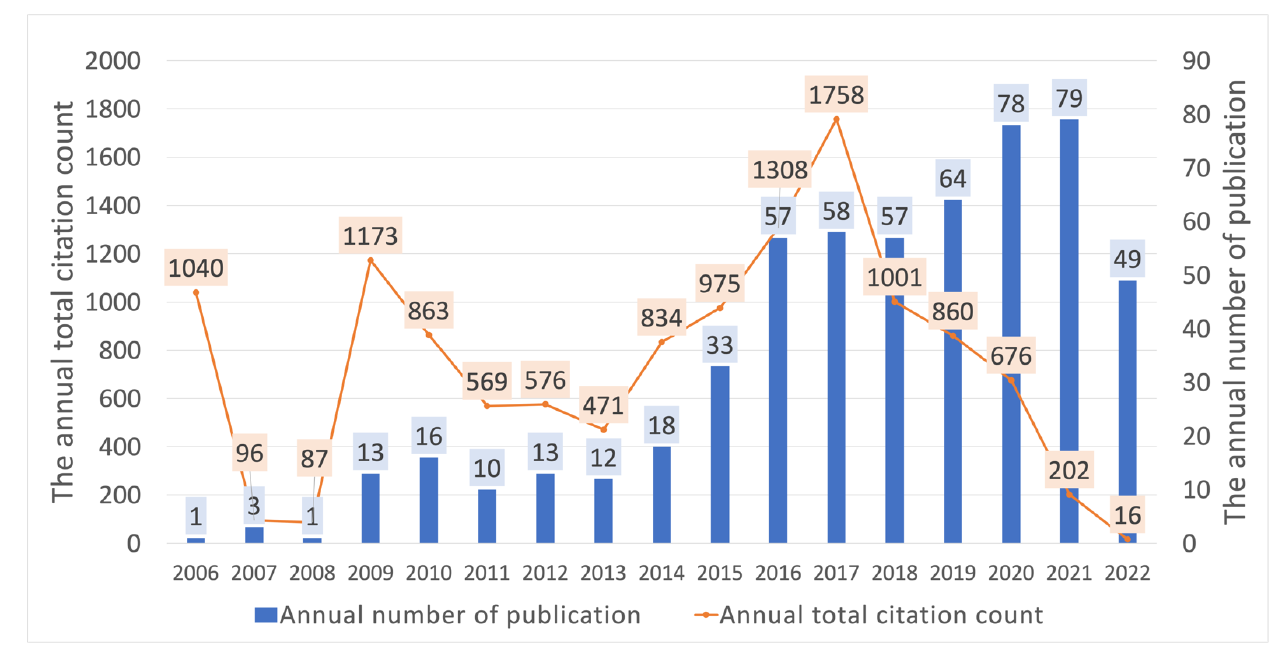
Figure 6. The annual total citation count and production of PRF studies. Table 2. Top 20 most-cited articles related with PRF in WoS.